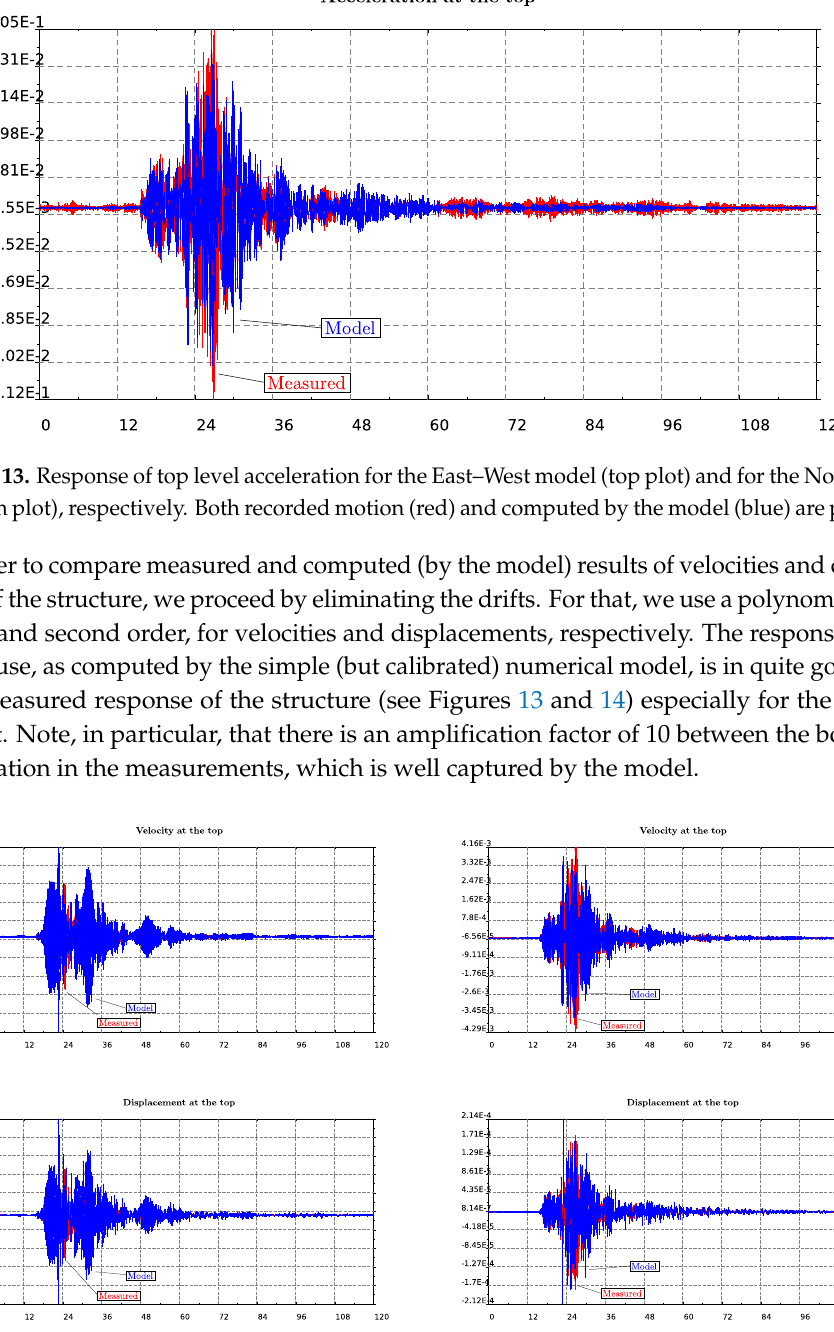
Figure 14. Response of top level velocities (top) and displacements (below) for the East–West model (left) and for the North–South (right), respectively. Both recorded motion (red) and computed by the model (blue) are